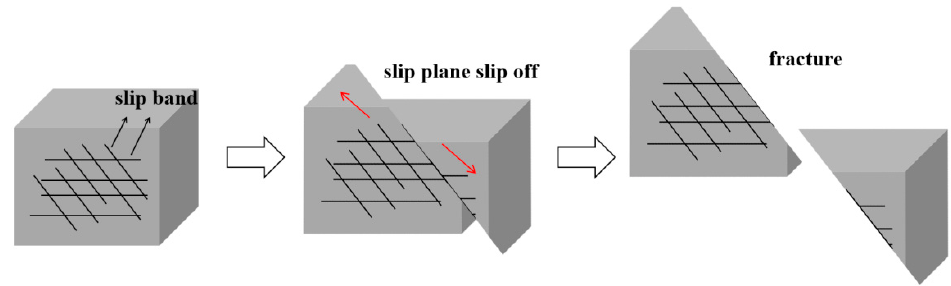
Figure 7. Schematic diagram of the brittle fracture slipping-off mechanism.